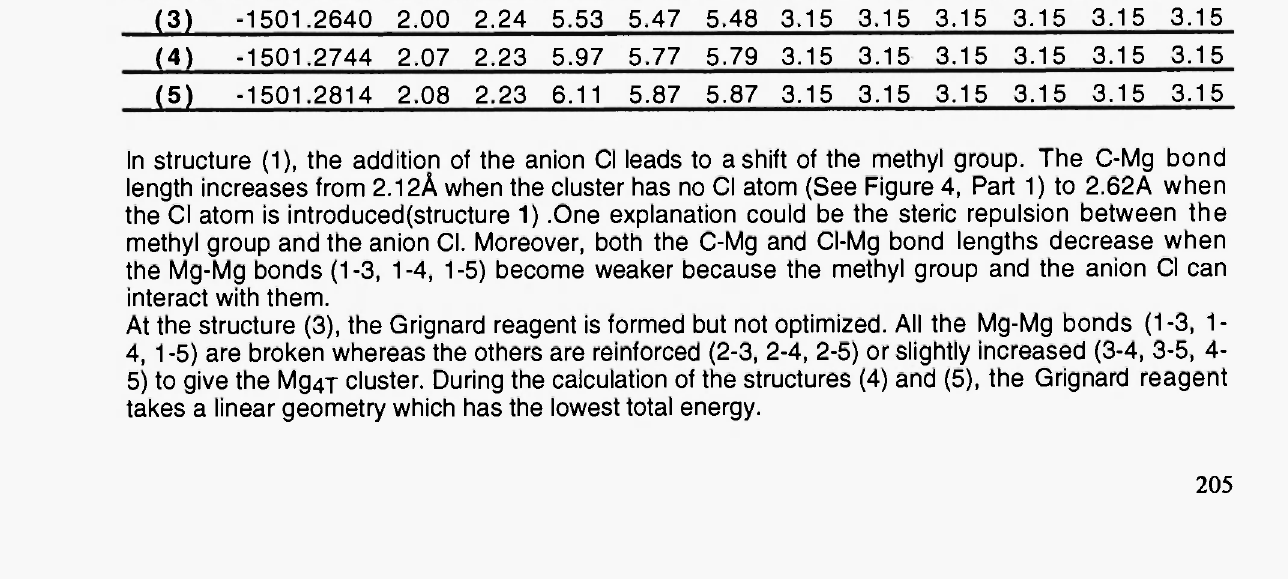
Table 3 : Total energies and interatomic lengths in the formation of the Grignard reagent CHgMgCI Cluster Total